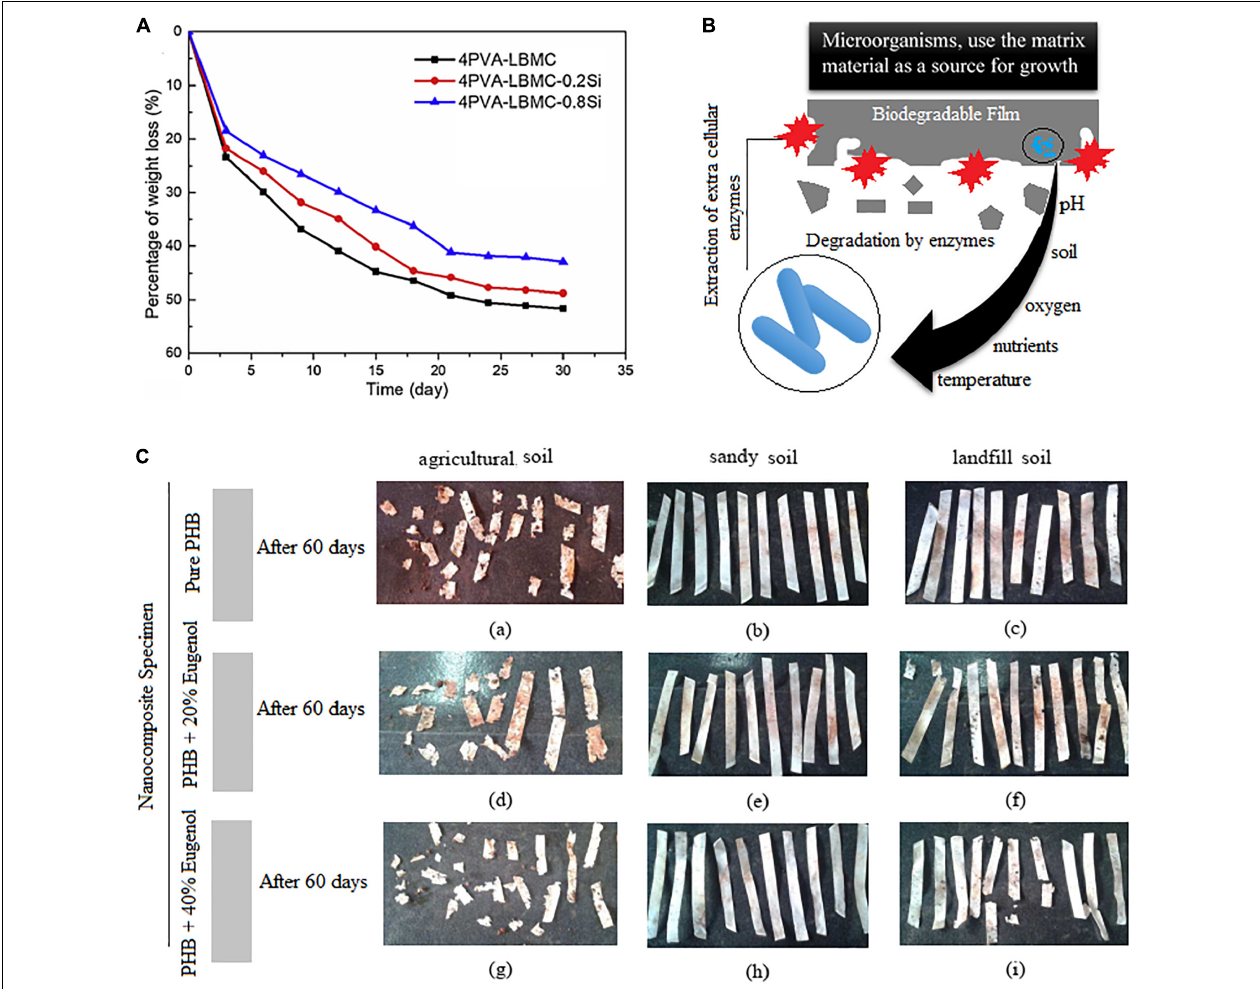
FIGURE 2 | (A) Biodegradation of the blend films in the soil [reproduced with permission from Zhang J. et al. (2020)]. (B) The mechanism of biodegradation of the film matrix. (C) Pure polyhydroxybutyrate (PHB) films containing eugenol after 60 days of biodegradation. (a–c) Pure PHB. (d–f) PHB films containing 20% of eugenol. (g–i) PHB films containing 40% of eugenol [reproduced with permission from Rech et al.